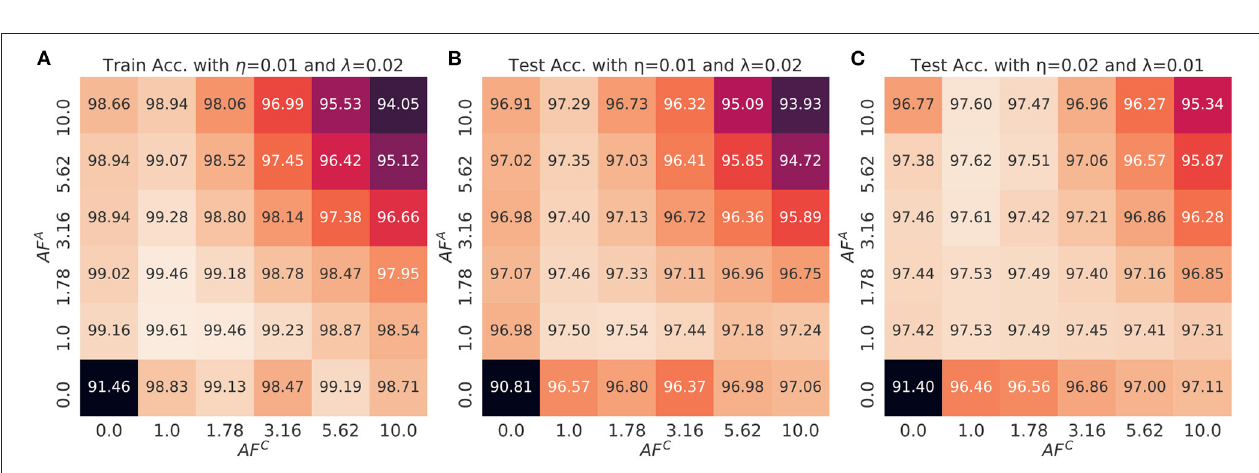
FIGURE 7 | The (A) train and (B,C) test accuracy of a multi-layer perceptron as a function of AF A and AF C . The displayed values are averaged over the last three epochs of the training and also three different initialization conditions. The mini-batch size is 1. The transfer learning rate and SGD learning rate is (0.01 and 0.02) for (B) and (0.02 and 0.01) for (C)